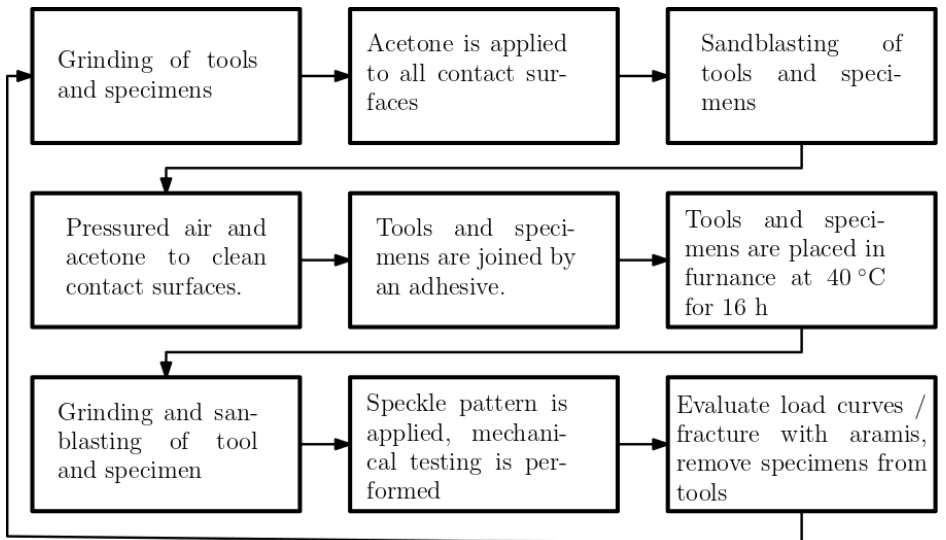
Figure 7. A flow chart for specimen preparation and